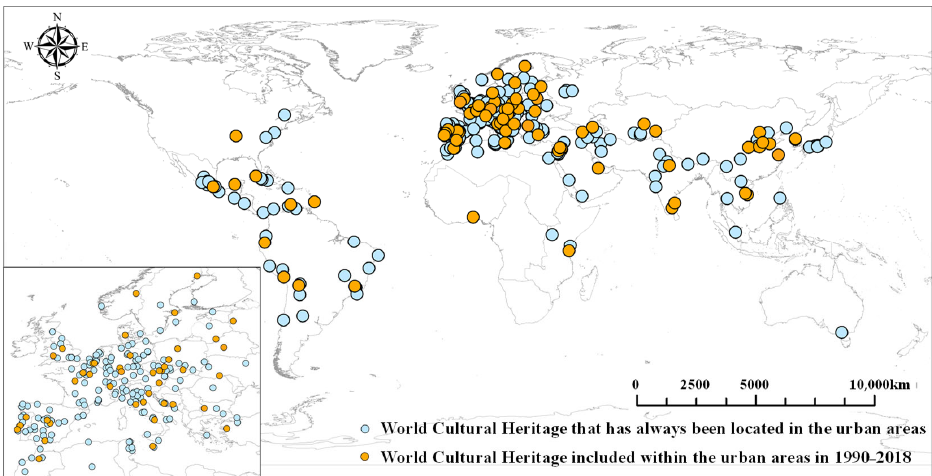
Figure 5. Spatial distribution of world cultural heritage sites.